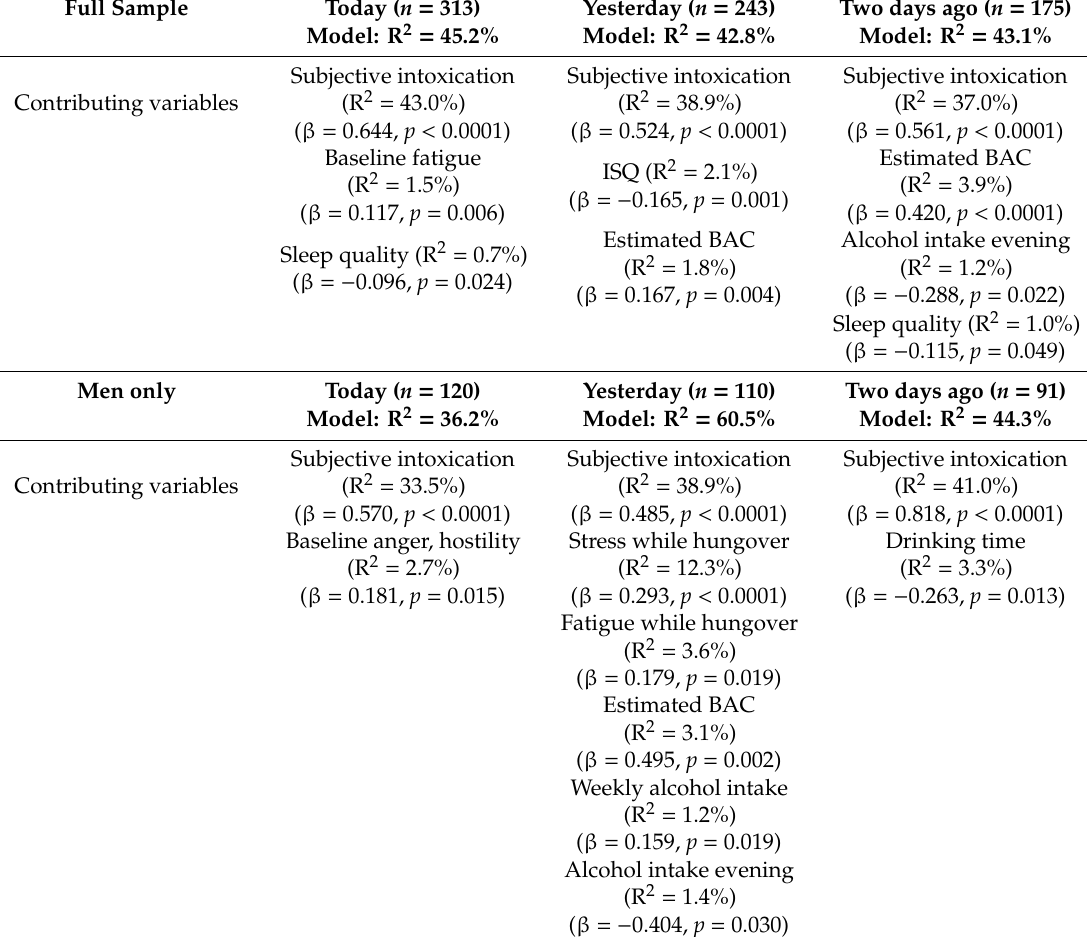
Table 3. Significant predictors of hangover severity (excluding next-day